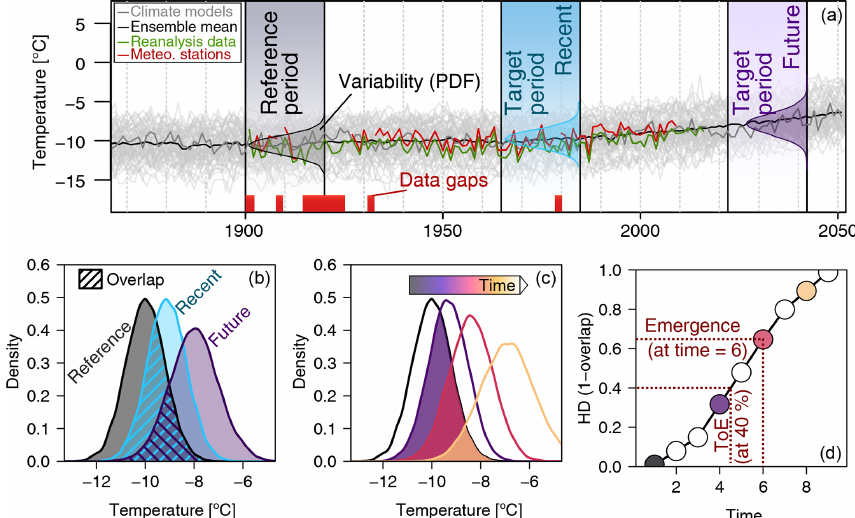
Figure 2. Schematic of the ToE method based on the Hellinger distance (HD). (a) Example of time series evolution from climate simulations, a meteorological station, and a reanalysis dataset. Natural variability as the PDF of the reference period and two example target periods with a window width of 21 years for recent and future assessment with a sketch of the corresponding PDFs. (b–d) The overlap between the PDFs of the reference and target periods (b) , a sketch of PDF evolution over time (c) , and the resulting HD as the dissimilarity of the target and subsequent reference PDFs (one minus the overlap). Exemplary determination of the ToE for a threshold of 40% emergence or emergence at a chosen time step, respectively (d)